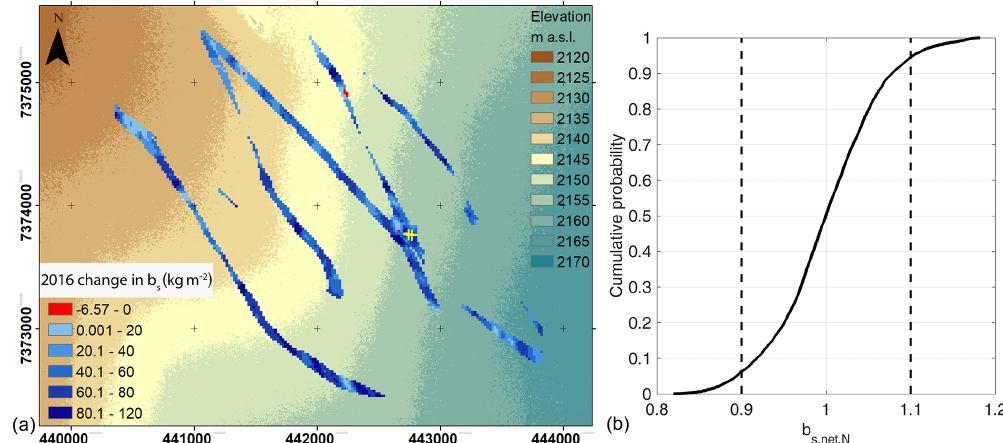
Figure 9. (a) Determined changes in accumulation ( b s ) from May 2016 until September 2016. The yellow crosses show locations of the upGPR. The background displays a 2m digital elevation model (Porter et al., 2018) with 5m contour color coding starting at 2120ma.s.l. (brown color) and reaching 2165ma.s.l. (blue color). The coordinates are given according to UTM with datum WGS 1984. (b) Cumulative probability distribution of the normalized net accumulation ( b s , net , N ) of the layer between end-of-melt-season 2015 and end-of-melt-season 2016 layers.